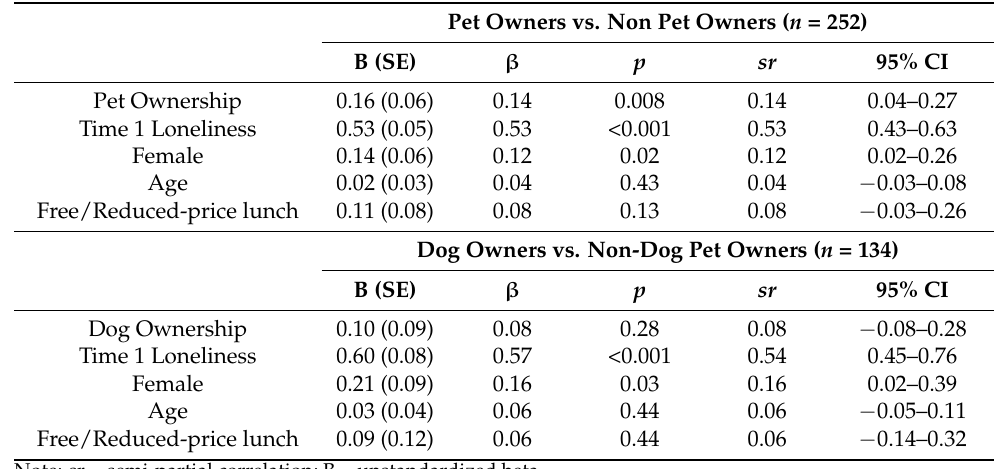
Table 3. Pet ownership and dog ownership predicting Time 2 loneliness, controlling for Time 1 loneliness, gender, age, and free/reduced price lunch